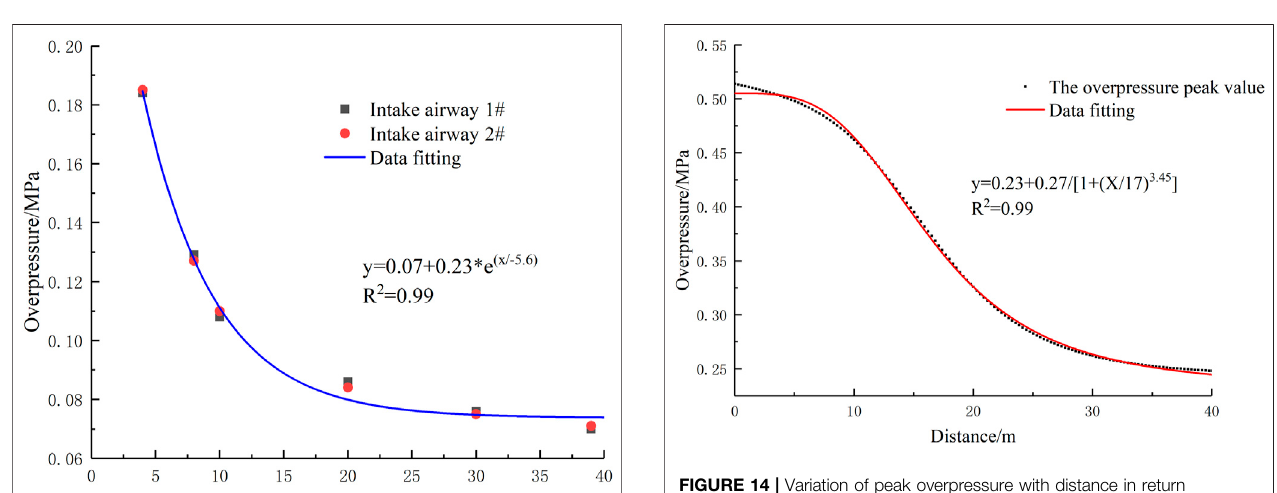
FIGURE 14 | Variation of peak overpressure with distance in return airway. TABLE 4 | Statistical table of attenuation rate of peak overpressure per 10 m in intake airways 1 and 2. Name of roadway